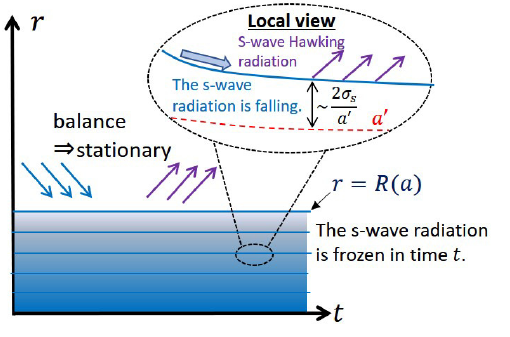
Figure 14. Stationary black hole in the heat